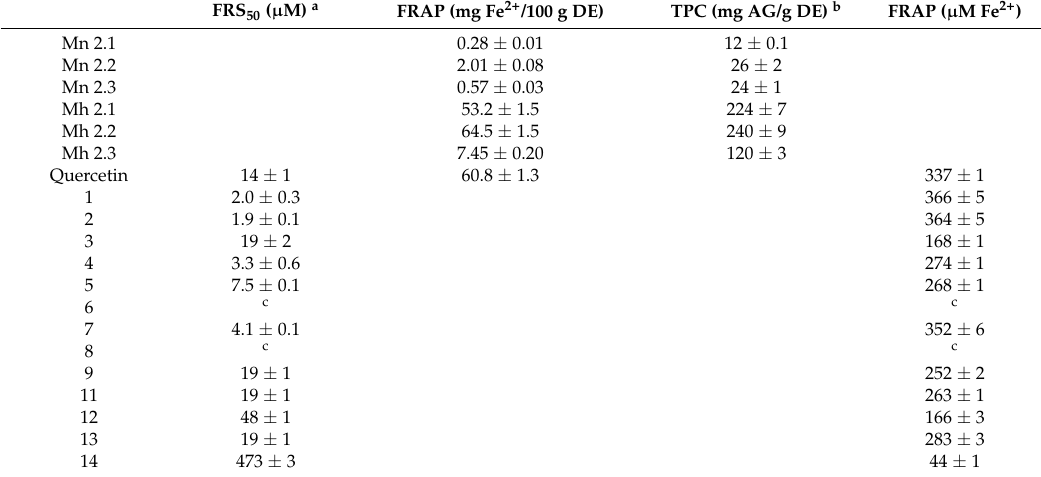
Table 1. Antioxidant activity of extracts and compounds from the aerial parts of M. nobilis and M. hernandoi